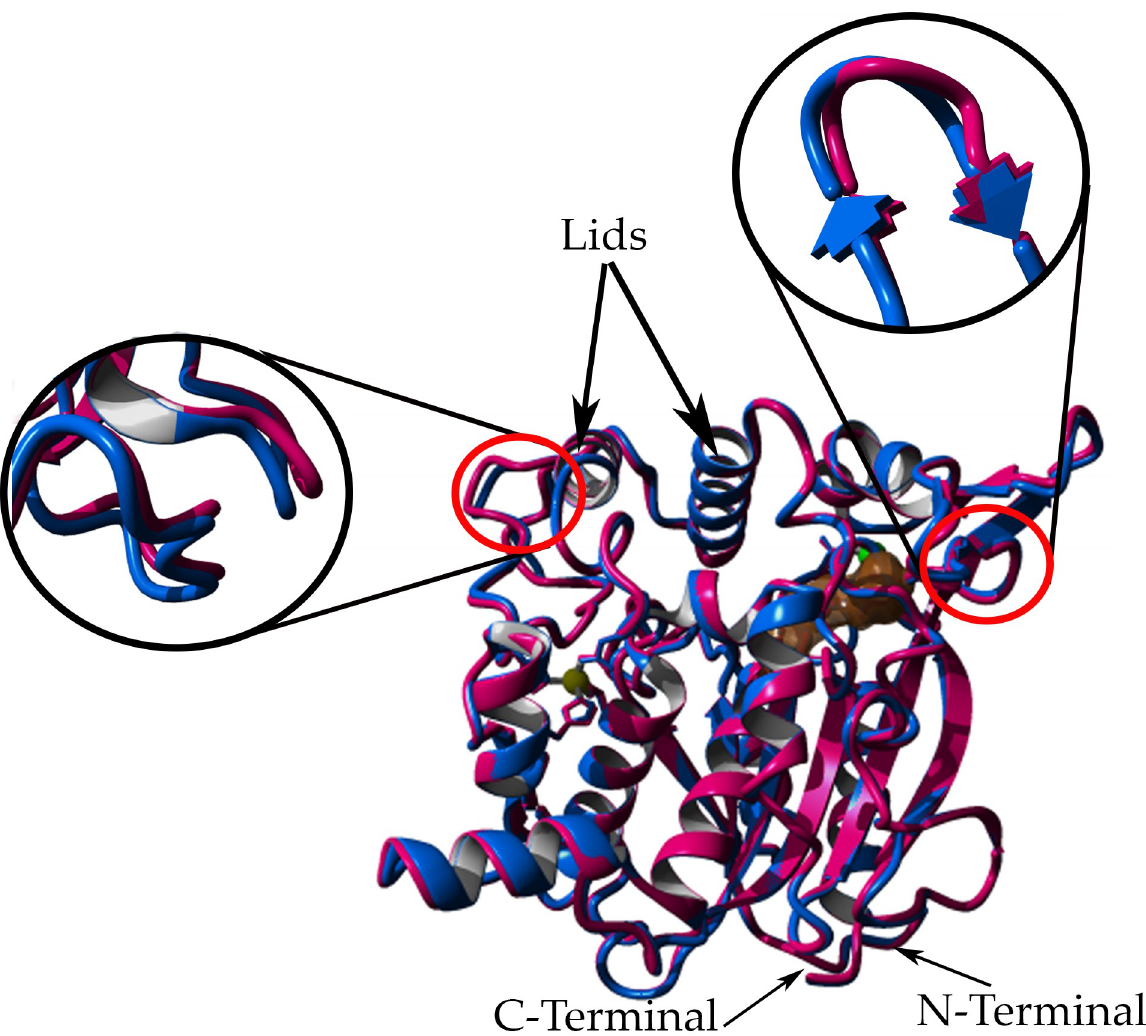
Fig 5. Structural alignment of 5M (7BUK) chains A and B. Chain A colored in magenta, chain B colored in blue, yellow ball represents a zinc ion, the green ball represents calcium ion, brown surface residues represent the catalytic triad of lipase. The image was generated via YASARA